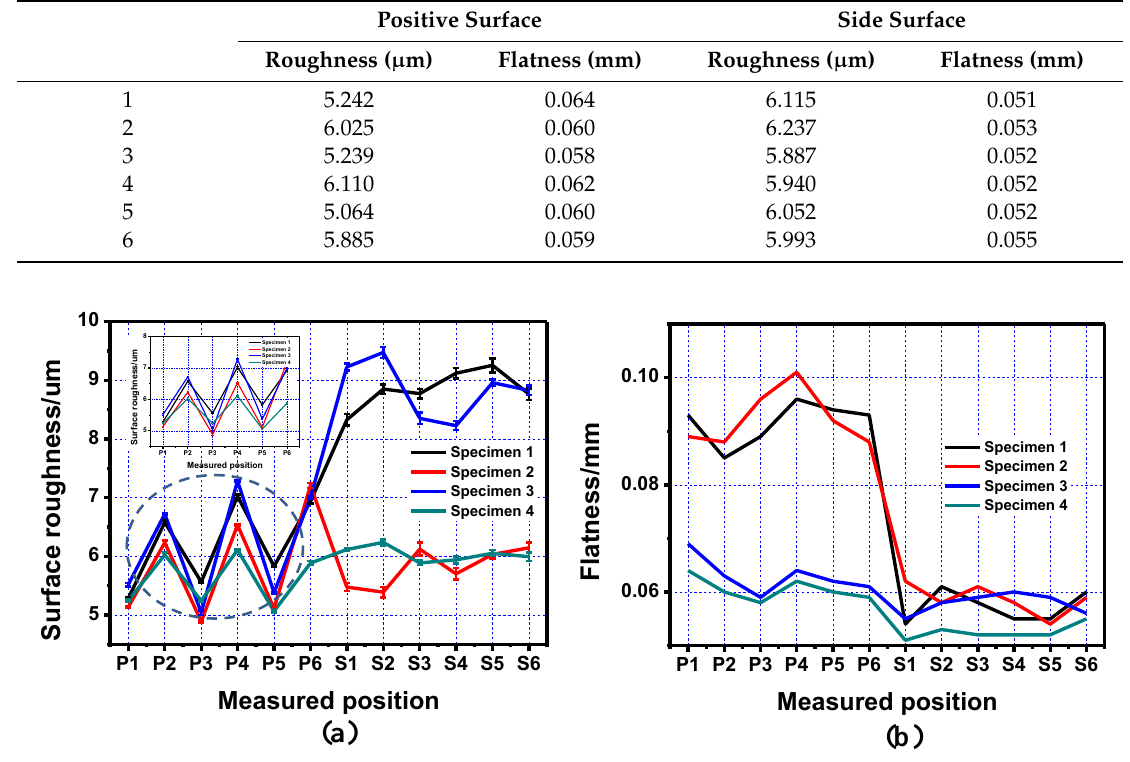
Figure 10. Line charts of roughness and flatness on the positive and side surfaces of the inner structure, printed using three di ff erent scan strategies and the modified scan strategy (Specimen 4). ( a ) Surface roughness of the four specimens; ( b ) Surface flatness of the four